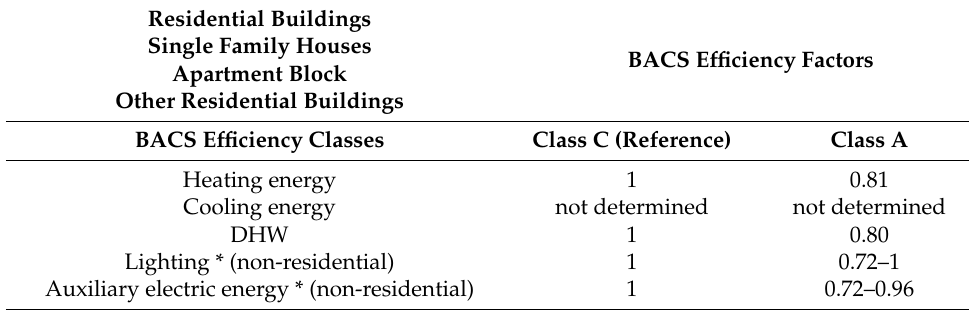
Table 6. The selected detailed BACS efficiency factors for residential